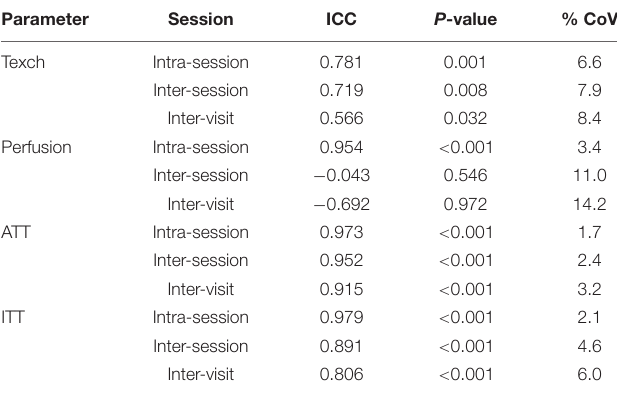
TABLE 2 | Reproducibility results of intra-session, inter-session and inter-visit ICC and CoV of the mean grey matter estimates for all parameters estimated with the extended